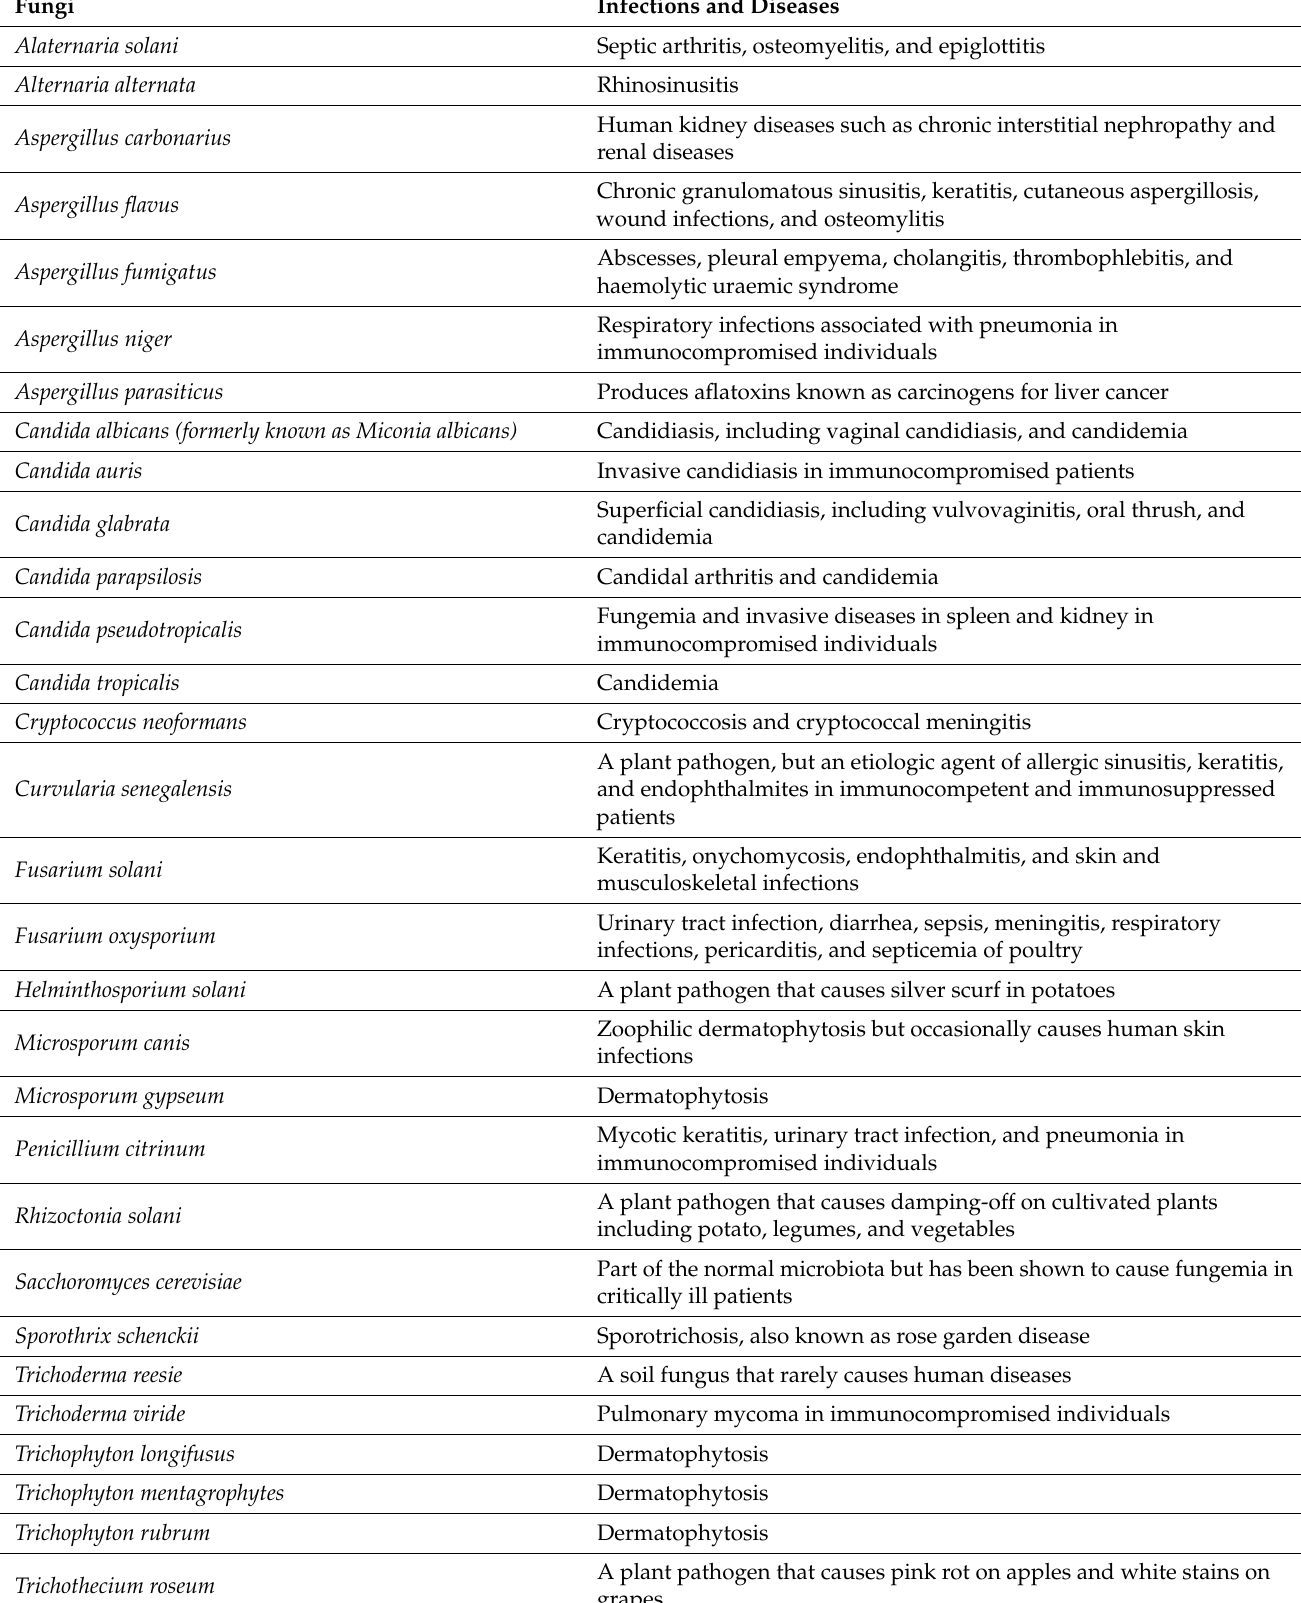
Table A2. A list of fungal species mentioned in the review and the diseases inflicted by